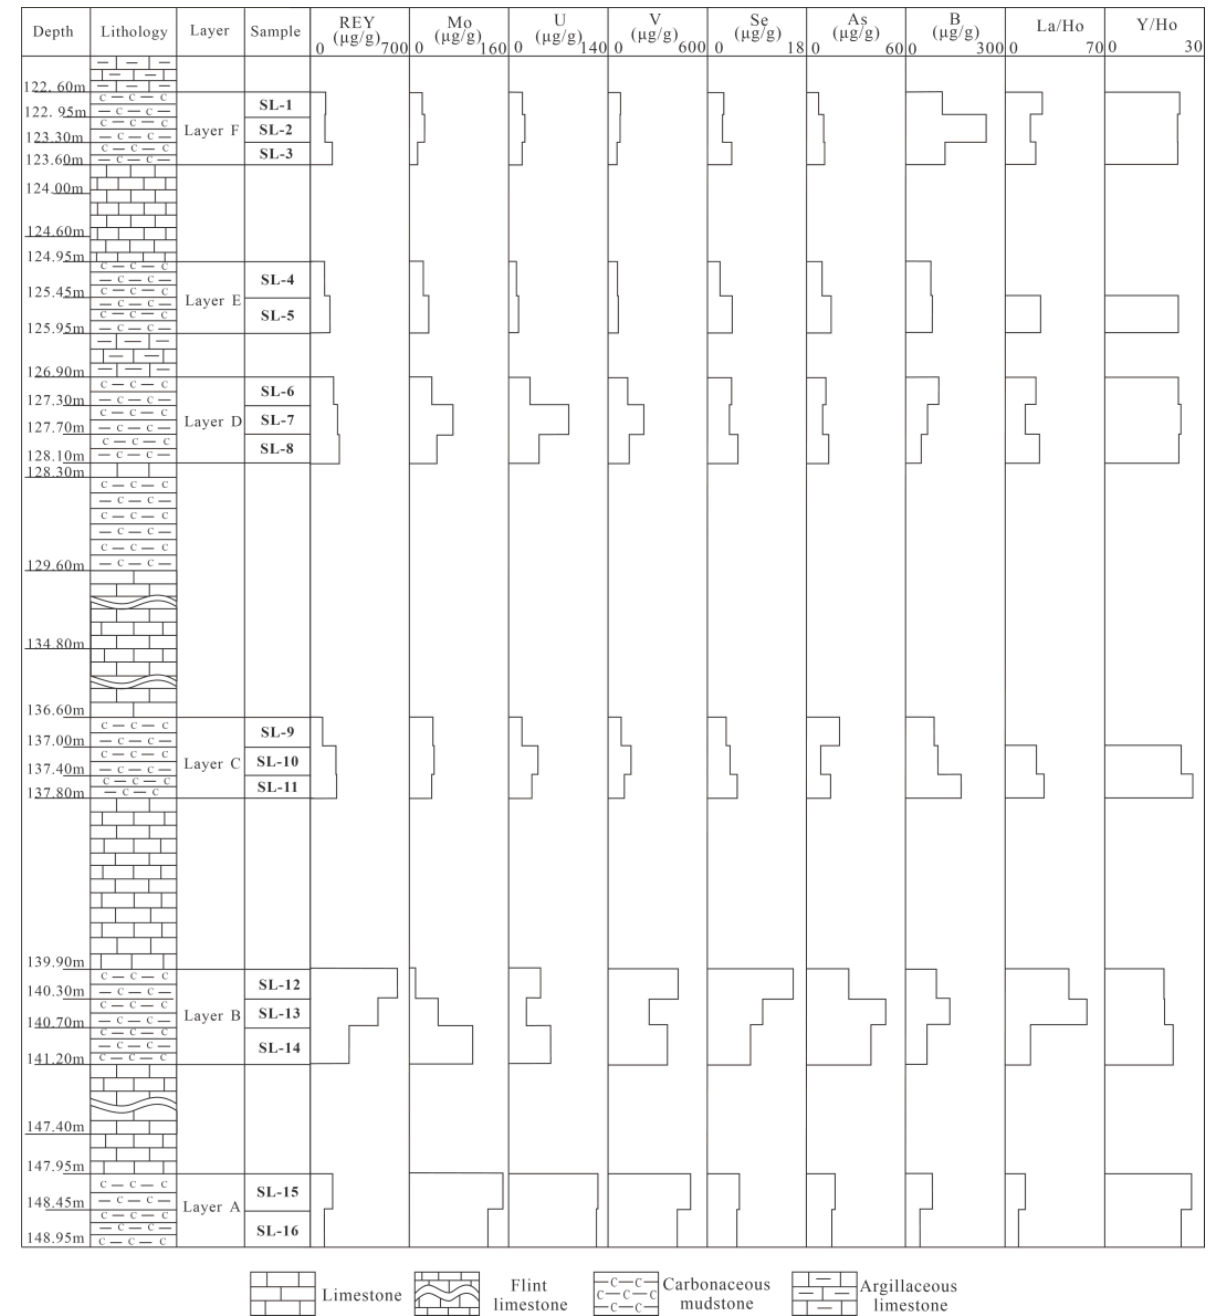
Figure 9. Vertical distribution of selected trace elements, La/Ho and Y/Ho, throughout borehole SL profile .